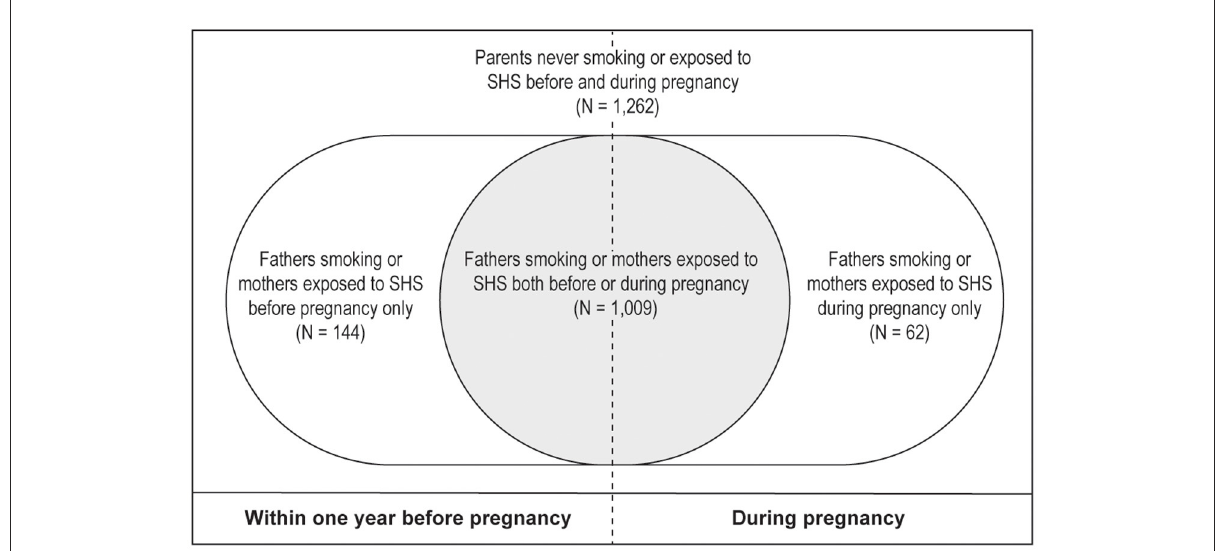
FIGURE2 The number of parents of different smoking exposure patterns before and during pregnancy.